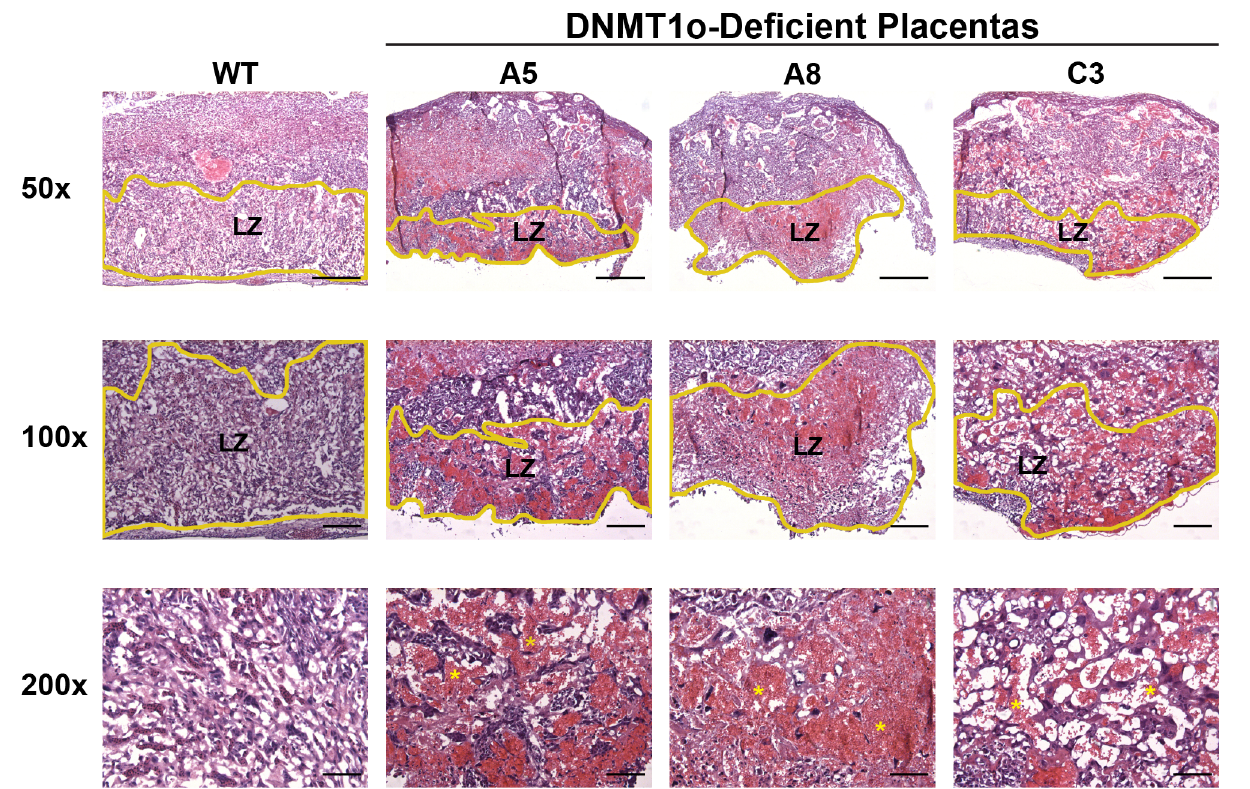
Fig 4. Histology of hematoxylin and eosin (H&E) stained labyrinth of one wild-type (wt) three DNMT1o-deficient low- Peg10 gDMD methylation placentas. The scale bars for 50X, 100X and 200X magnification are 500, 200 and 100 μ m respectively. Yellow lines in 50x and 100x magnification images outline the labyrinthine zone